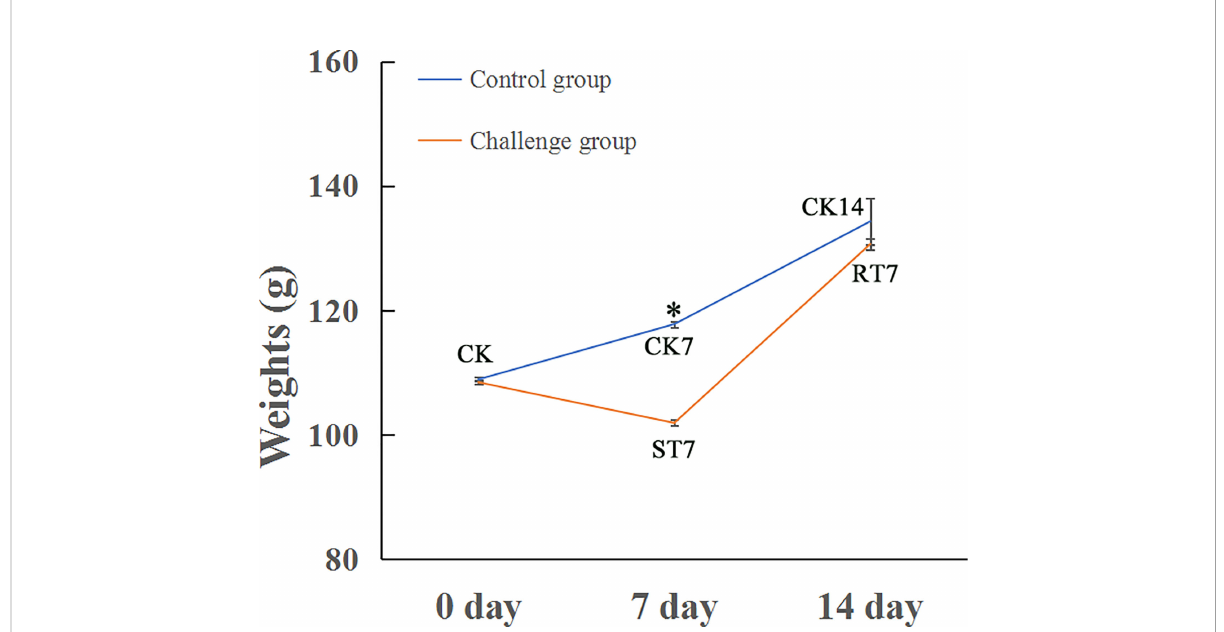
FIGURE 1 Growth curves of golden pompano under normal feeding, starvation, and refeeding. Asterisk indicated signi fi cant difference between two groups ( p < 0.05); blue line represents the growth curve for control group (CK); red line indicates the growth curve for the challenge groups (starvation and refeeding